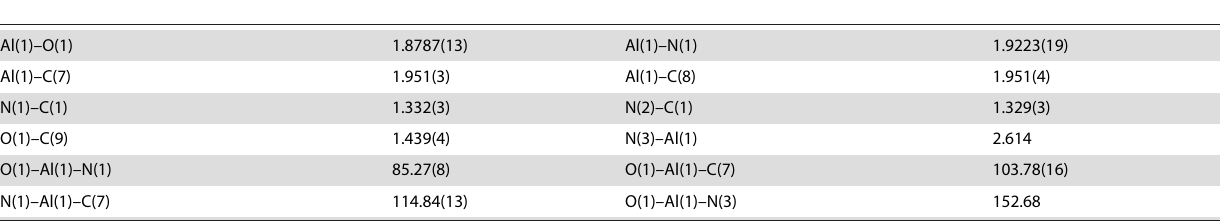
Table 4. Selected bond lengths (A˚) and angles (deg) for 3 .